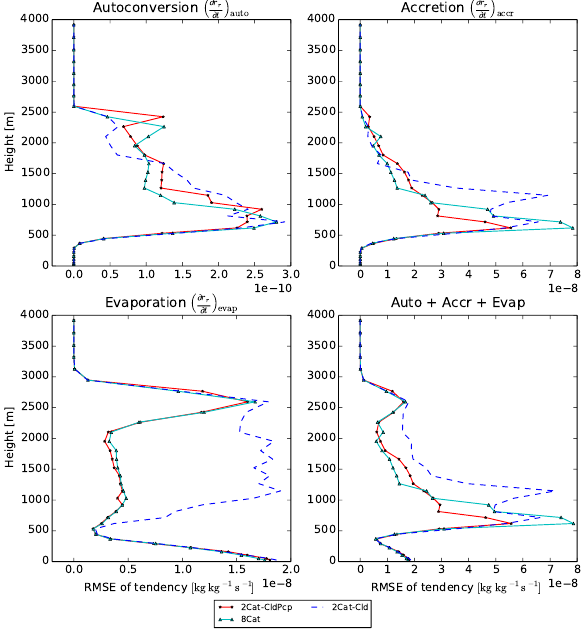
Figure 3. RICO: mean profile plots of the four tendencies. The sim- ulations in these plots use 32 sample points. For each configuration, an ensemble of 12 simulations is used, each with a different seed. Profiles are averaged over all 864 timesteps of the simulation and all 12 ensemble members. It is seen that all SILHS sampling methods are clearly convergent at all height levels.